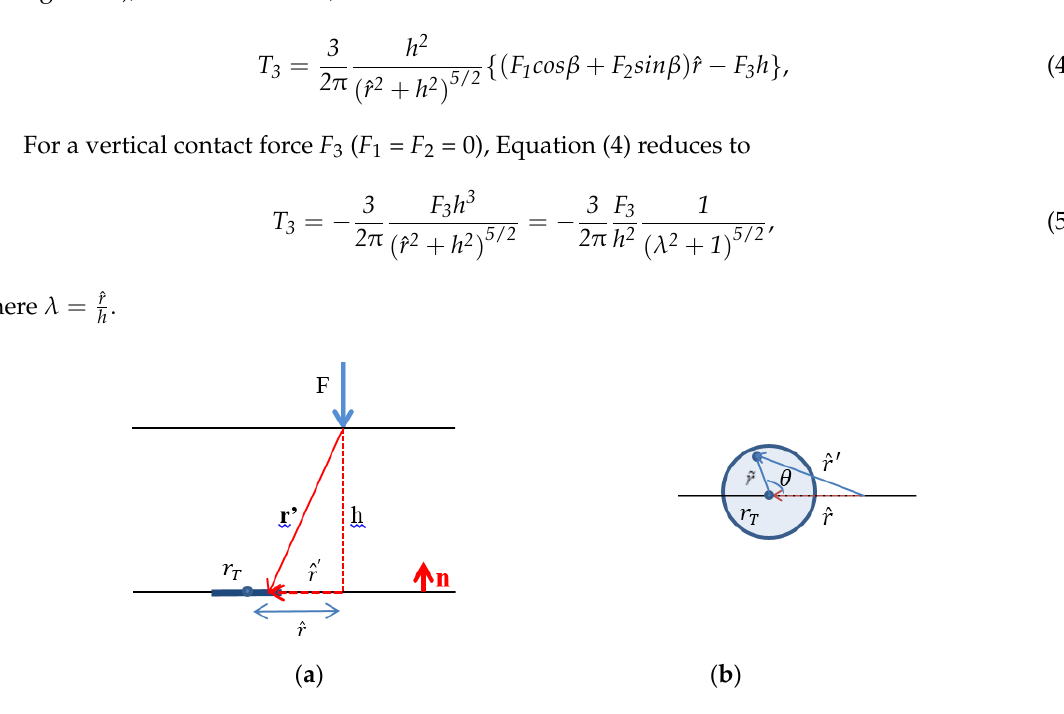
Figure 3. ( a ) View side, ( b ) Top side.